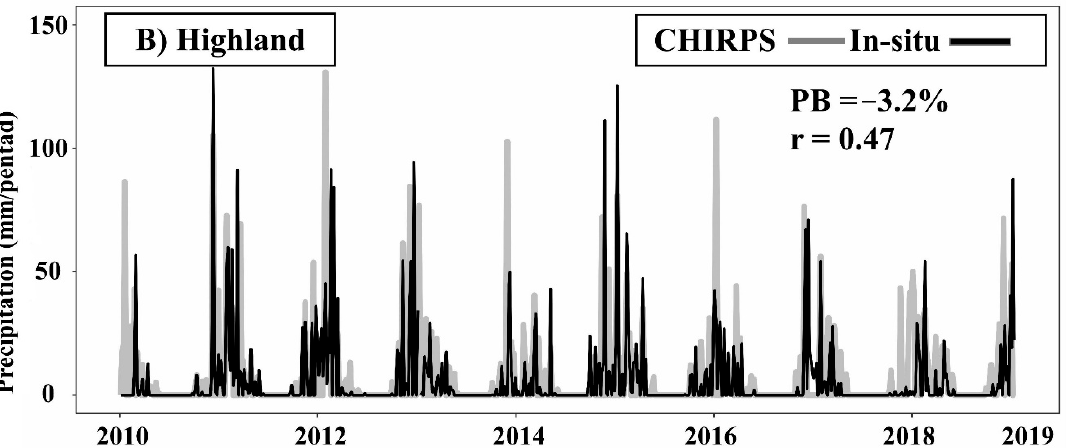
Figure 2. Pentad time series comparison between CHIRPS product precipitation estimates and in-situ precipitation measurements between 2010 and 2019, at ( A ) inland part and ( B ) highland part.